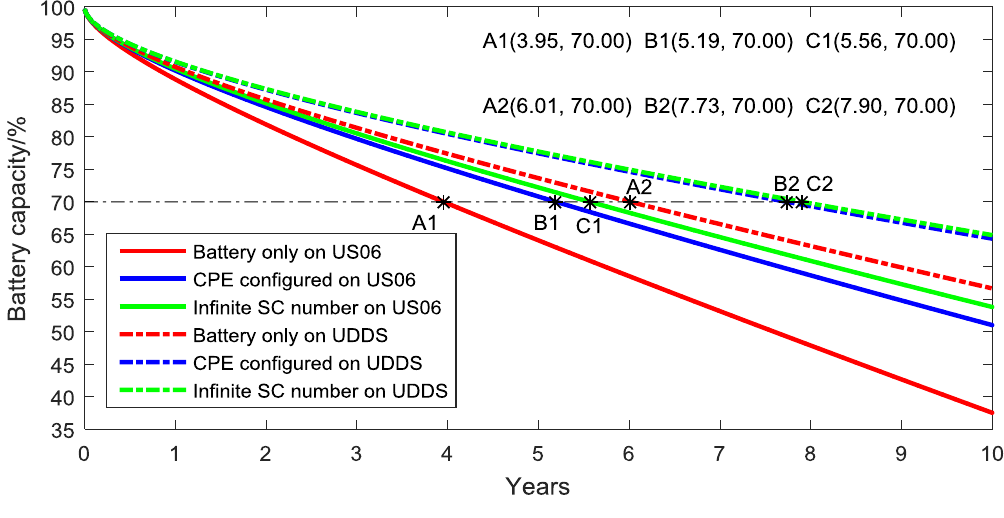
Table 8. Battery degradation percentage over vehicle lifetime.